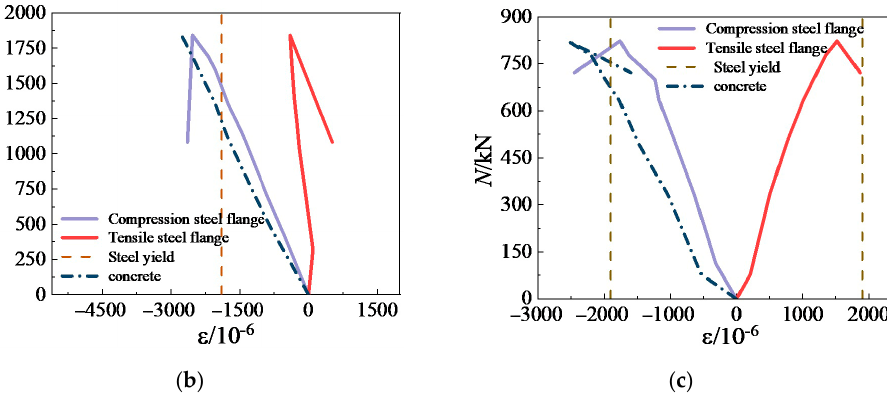
Figure 9. The strain curves of the steel and concrete of the typical specimens: ( a ) specimen A3; ( b ) specimen E1; ( c ) specimen E2.